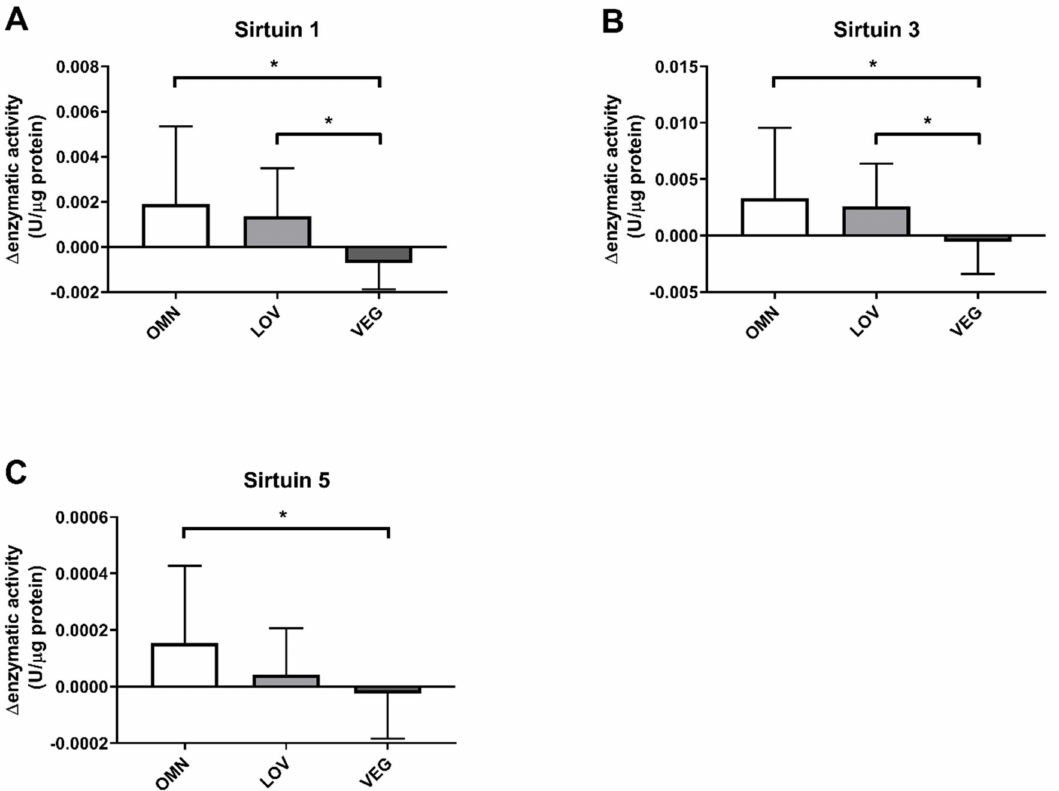
Figure 2. Changes of enzyme capacity (under substrate saturation) of sirtuins SIRT1, SIRT3, and SIRT5 after exercise. The response of sirtuins to exercise was calculated as the di ff erence of enzyme capacities before (pre) and after (post) exercise. Sirtuins in the three study groups of omnivores (OMN), lacto-ovo vegetarians (LOV), and vegans (VEG) are shown: SIRT1 ( A ), SIRT3 ( B ), and SIRT5 ( C ). Data are shown as mean di ff erence ± SD; n = 21–25; statistical analysis with Kruskal–Wallis test and Dunn´s multiple comparison test; * p <